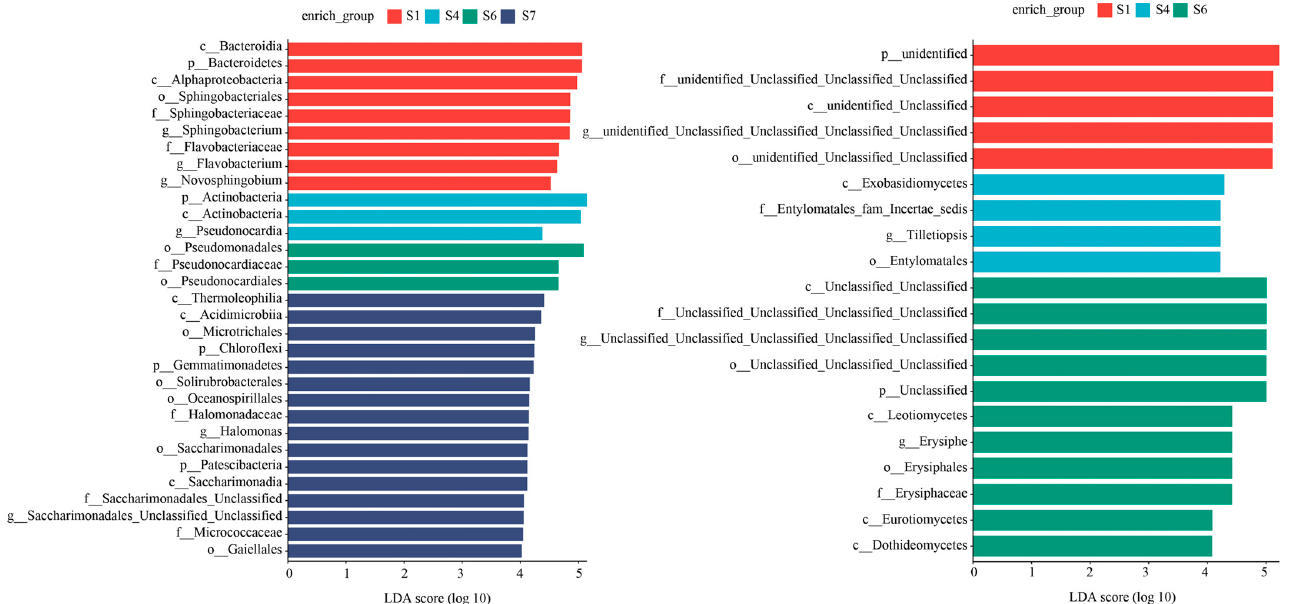
Figure 2. LEfSe analysis of the root endophytic bacterial and fungi community from the phylum to species rank across the different varieties (1,6 indicate the rot-conducive variety; 4,7 indicate the rot-suppressive variety) and farming modes (1,4 belong to monoculture mode; 6,7 belong to rotation mode).